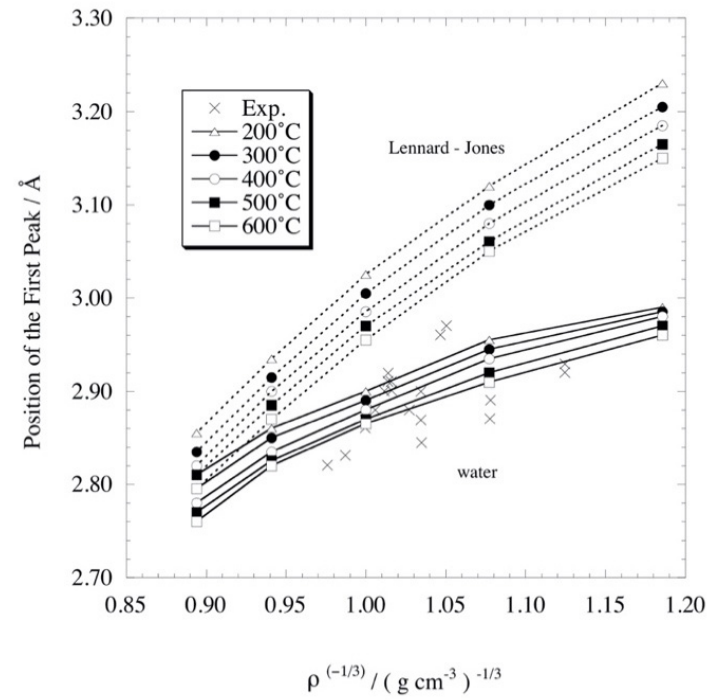
Figure 12. The nearest O–O distance with respect to the inverse of the cube root of the density. The solid lines are for water and the dotted ones are for Lennard-Jones fluids. Corresponding experimental data obtained from X-ray diffraction are marked by × . This figure is reprinted with permission from JCP , 1999 , 111 , 8545. Copyright 1999 AIP Publishing.